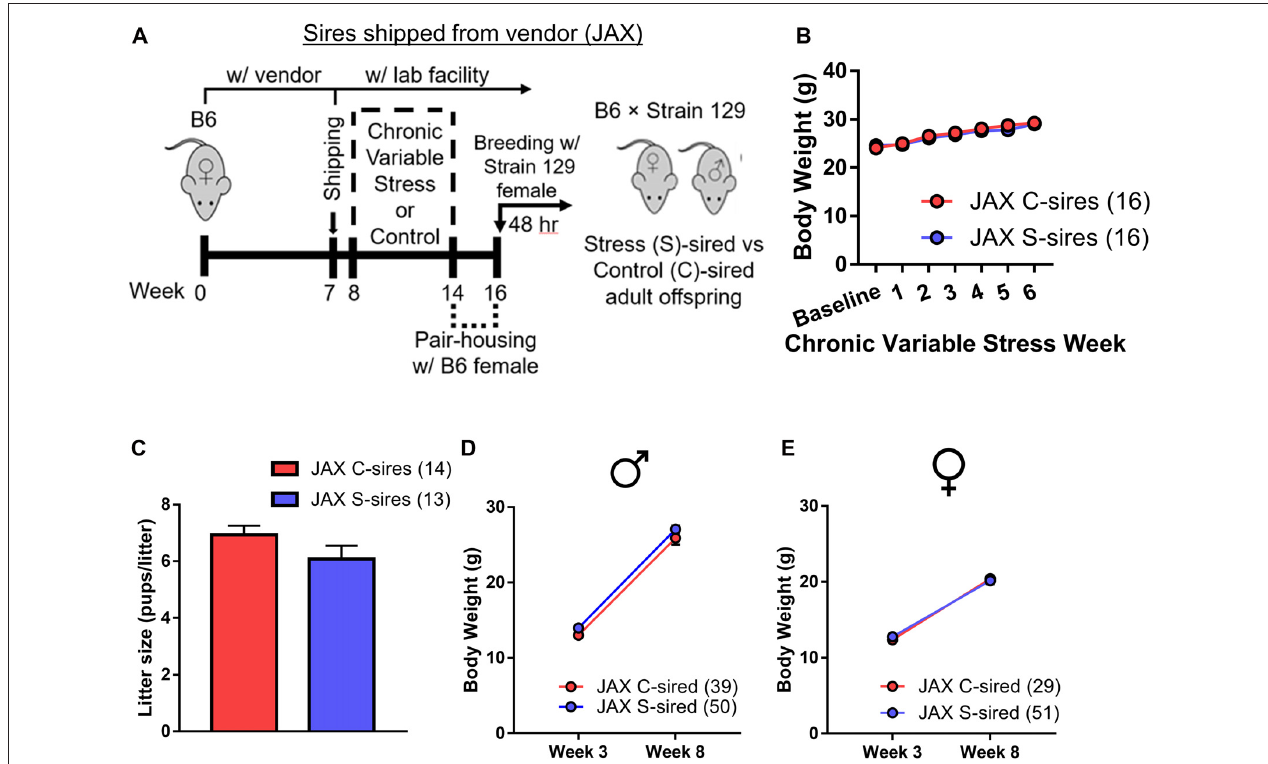
FIGURE 5 | Paternal chronic stress with vendor (JAX)-shipped sires. (A) Sires were shipped from JAX at 7 weeks postnatal to the animal vivarium before being exposed to chronic stress from 8 weeks to 14 weeks postnatal and, at 16 weeks, were bred to Strain 129 females to produce JAX S-sired and C-sired male